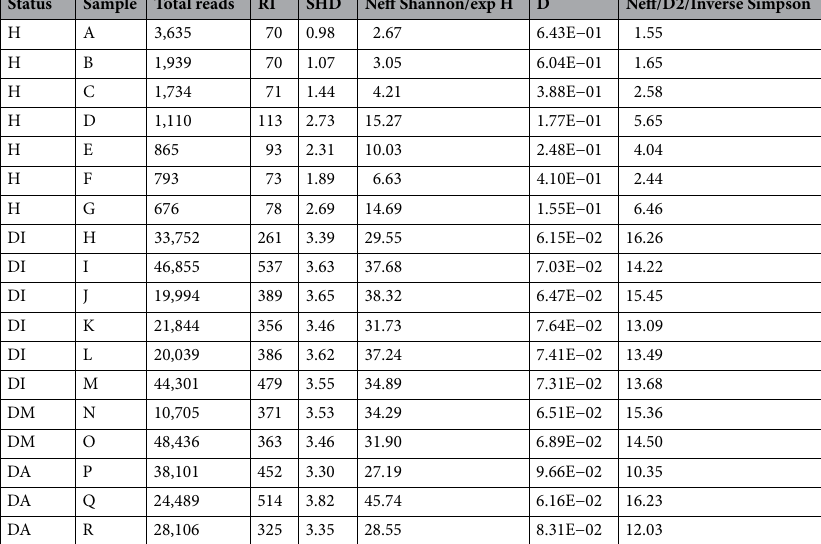
Table 1. The number of classified sequences obtained from each analyzed stage of tissue necrosis. Status: Healthy (H); initial disease (DI); intermediary disease (DM); advanced disease (DA). Richness indices (RI),